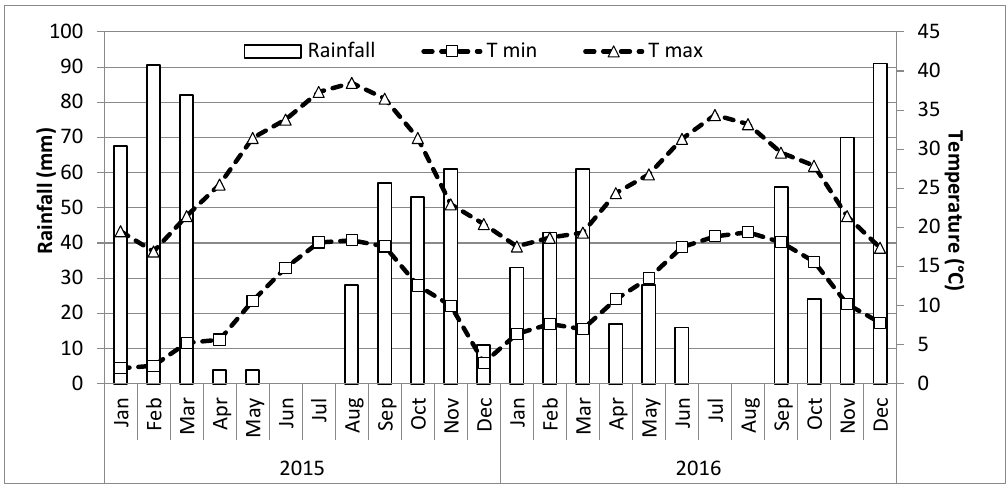
Figure 6. Monthly averages of maximum and minimum air temperatures and cumulative rainfall registered during artichoke growing cycle.